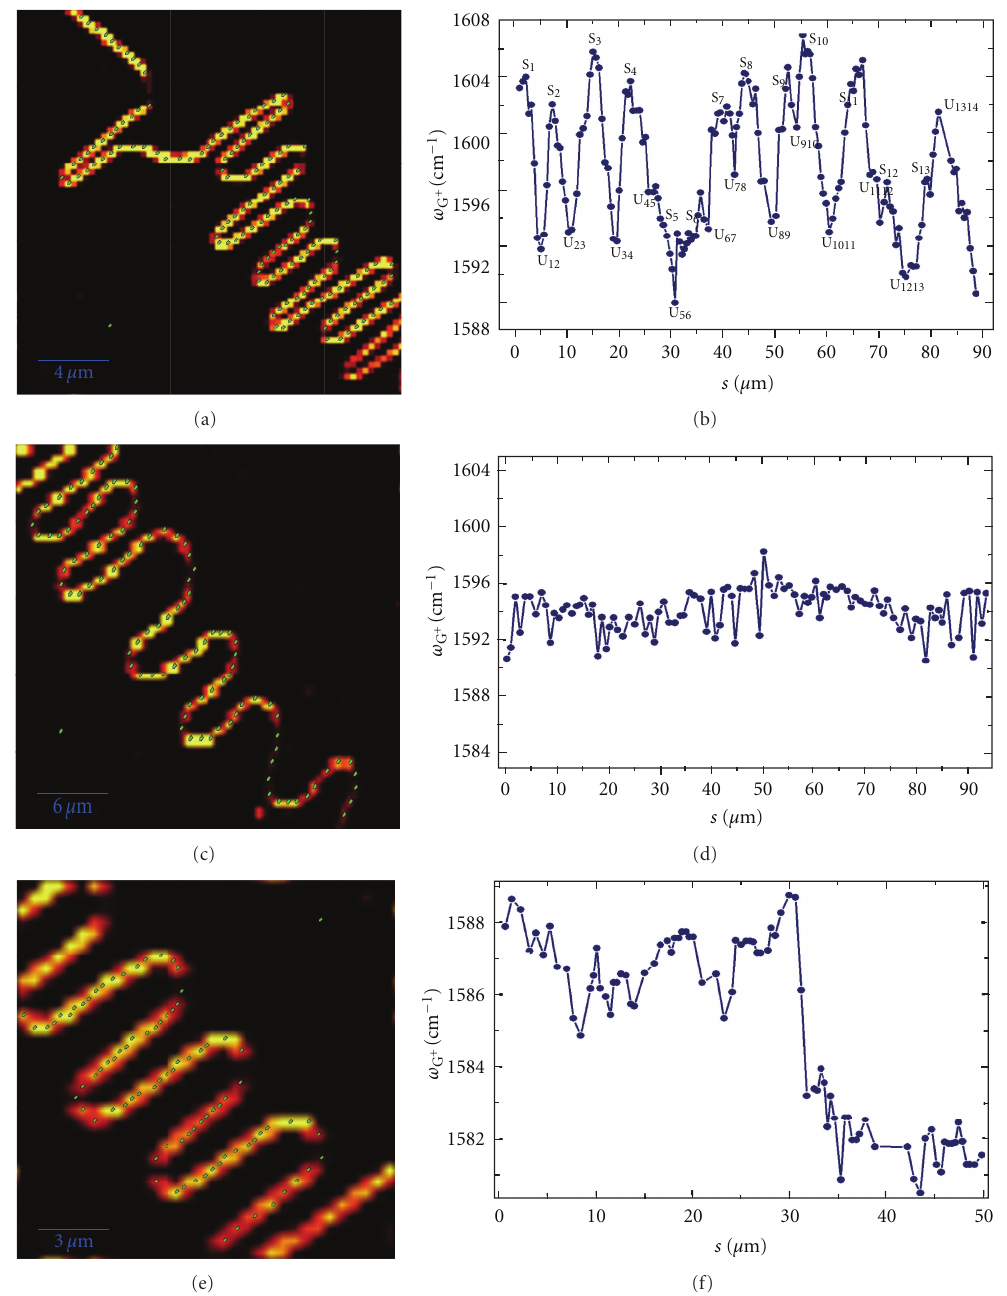
Figure 5: (a), (c), and (e) show spectroscopic images of G band of SWNT serpentines on quartz substrate, using the excitation laser wavelength of 532 nm ( E laser = 2 . 33 eV). (b), (d), and (f) show the G + frequency of these SWNTs, observed in all points indicated by green pointers in (a), (c), and (e), respectively, plotted as a function of the distance s , measured along the SWNT: (b) frequency has maximum and minimum following the tube-substrate morphology (a); (d) variation in frequency within experimental accuracy; (f) frequency “jumps”